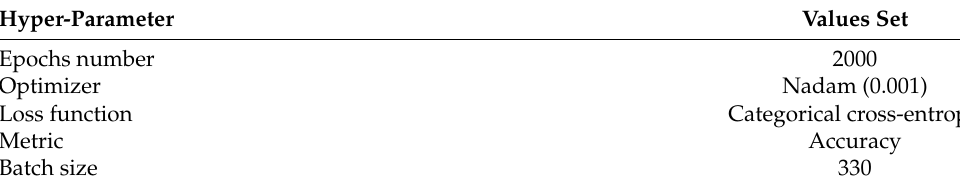
Table 3. The summary of configured hyper-parameters for the EEGNet’ model